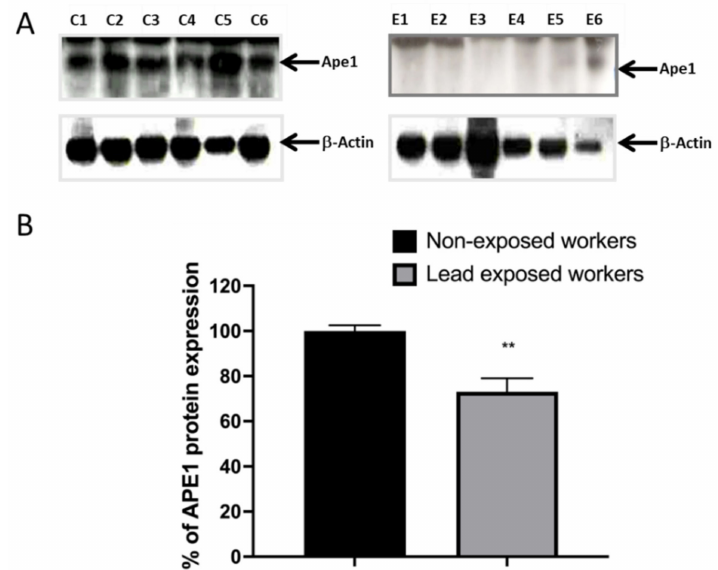
Figure 3. Occupational lead exposure decreases the protein level of Ape1. From total proteins extracted from lymphocytes of lead-exposed and non-exposed workers, APE1 immuno-blot was performed. ( A ) Representative immuno-blots (C1–C6) for Ape1 of all non-exposed workers ( n = 16) and representative immuno-blots (E1–E6) of all lead exposed workers ( n = 37). ( B ) Bar graphs show relative densitometry quantification, data was normalized to β -Actin and represented as % as compared to control. Data are means ± S.E of at least three independent western blots of all workers involved into the bio-monitoring. Mann–Whitney t -test. ** p <